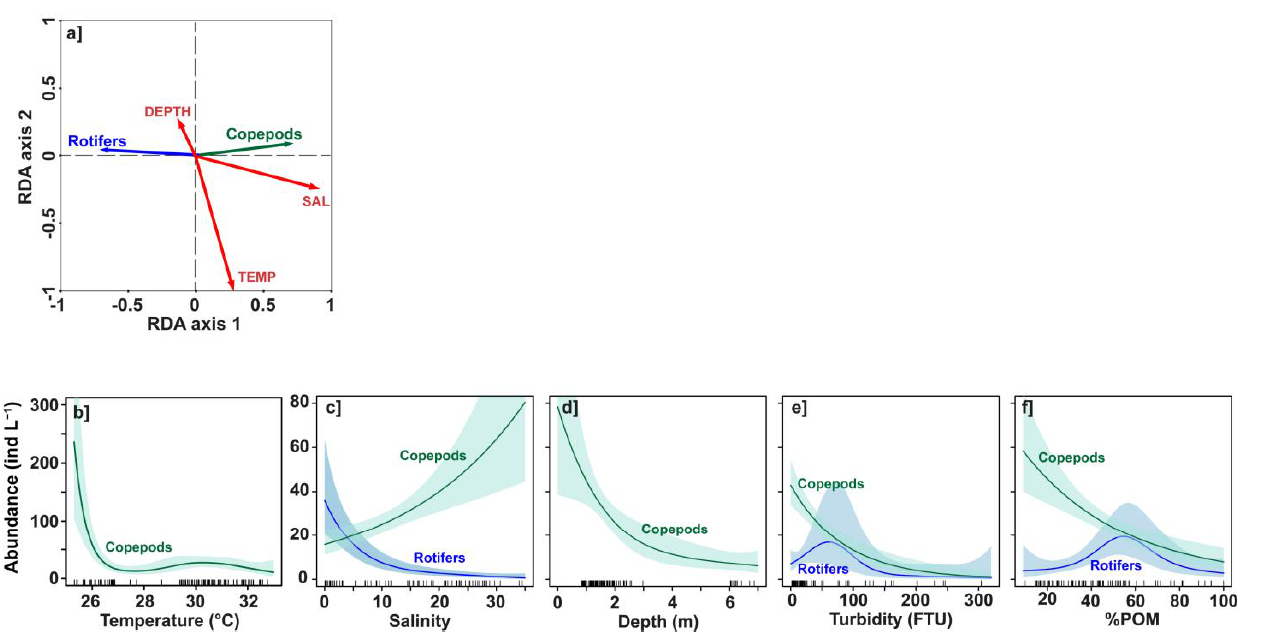
Figure 6. Redundancy analyses (RDA) and generalized additive models (GAMs) relating abundance of copepods and rotifers to environmental variables. ( a ) RDA diagram of abundances and environmental parameters. ( b – f ) GAMs of abundances versus temperature (TEMP), salinity (SAL), depth (DEPTH), turbidity (TURB) and dissolved oxygen (DO). Only significant ( p < 0.05) relationships are shown for copepods and rotifers. Note the change in scale between subplots ( b ) and ( c – e ). Shaded areas indicate the 95% confidence intervals.